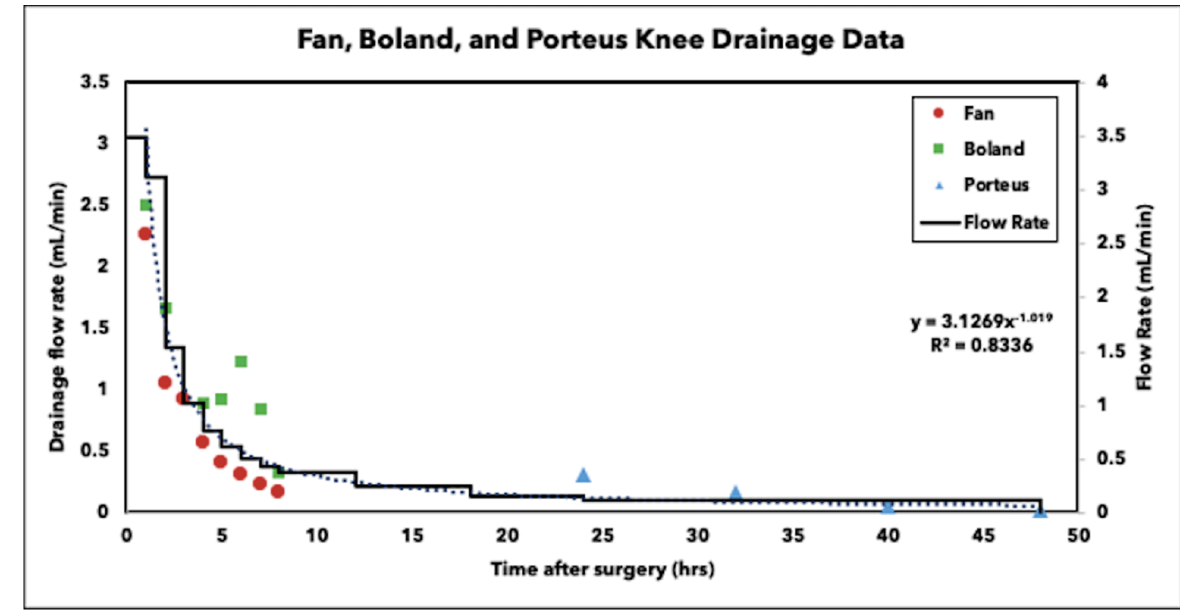
Figure 1. Drainage flow observed after knee arthroplasty revision surgery from Fan, Boland and Porteous studies. The curve fit data were used to generate the stepwise flow rate decrease in the reactor system.